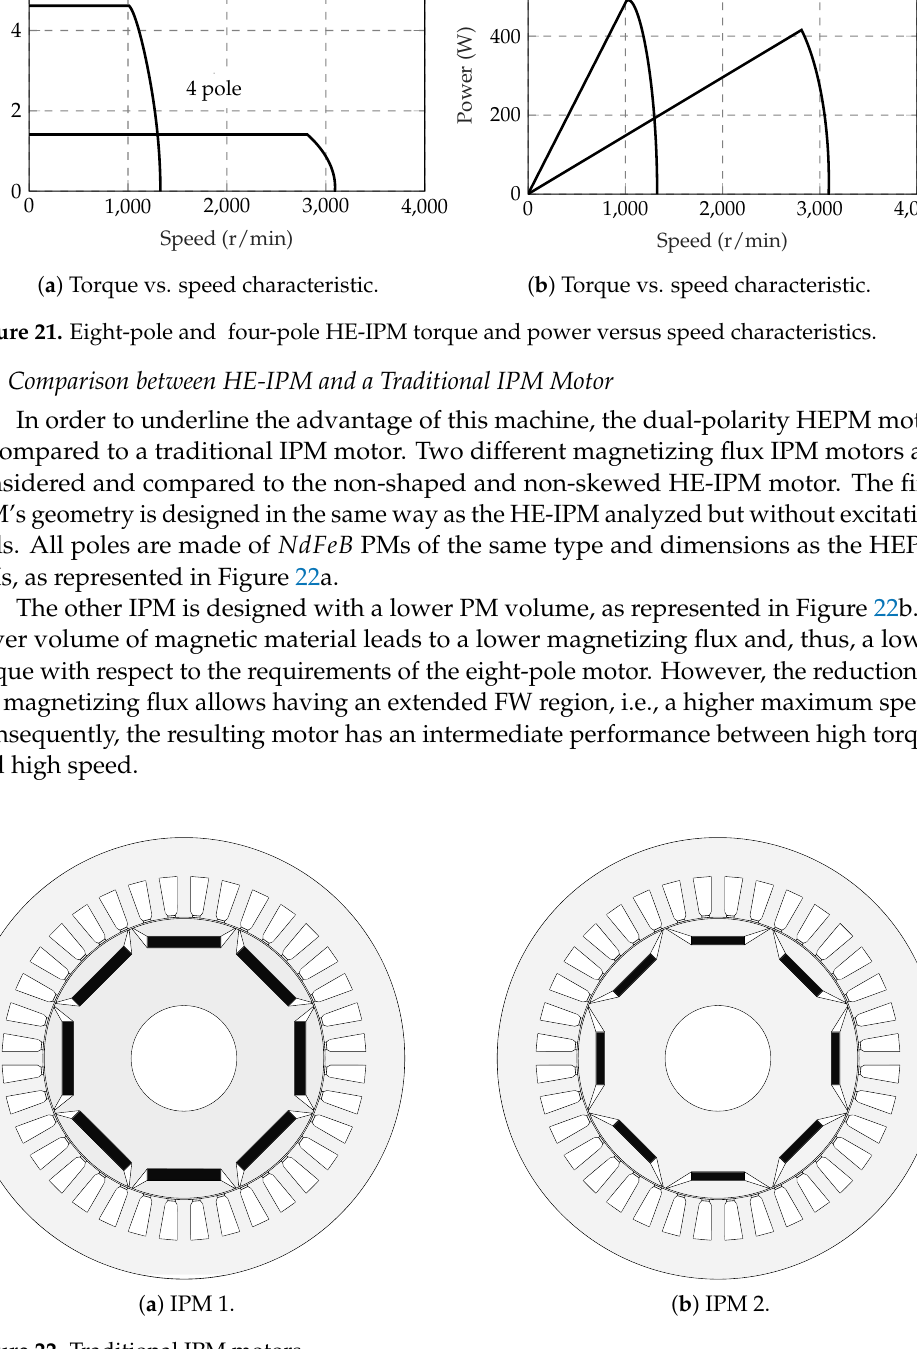
Figure 22. Traditional IPM